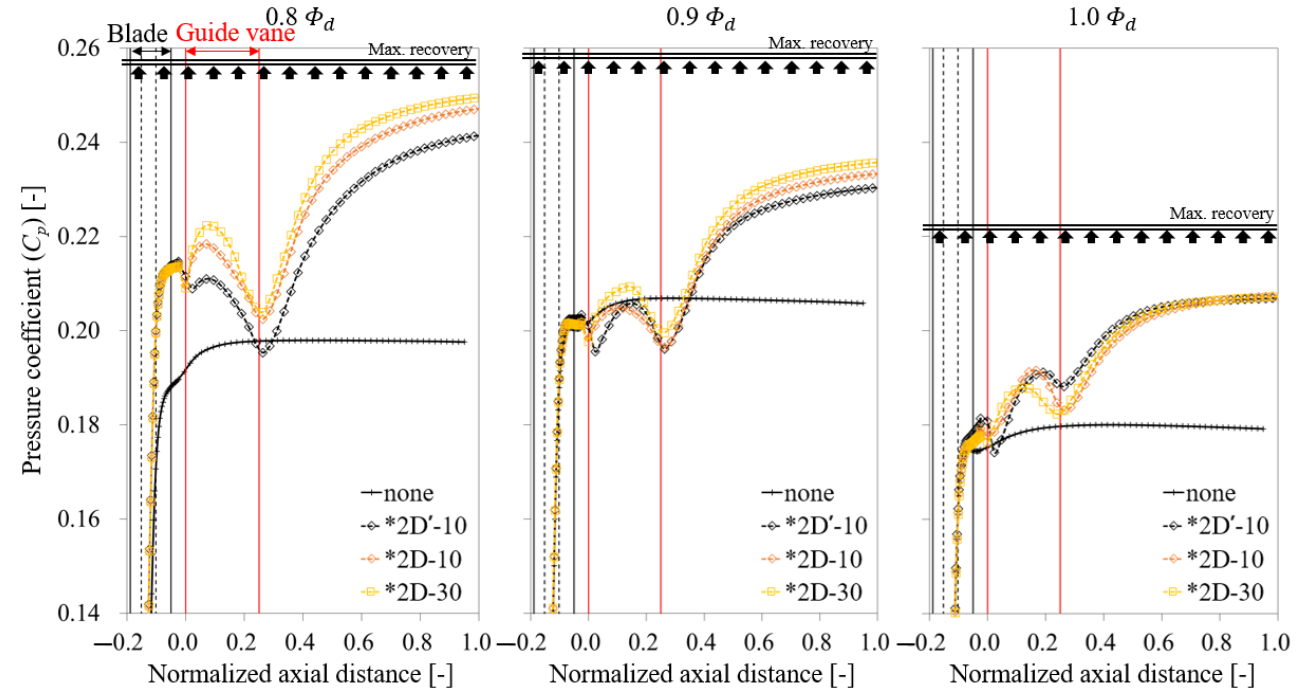
Figure 15. Static pressure rise in axial distance.